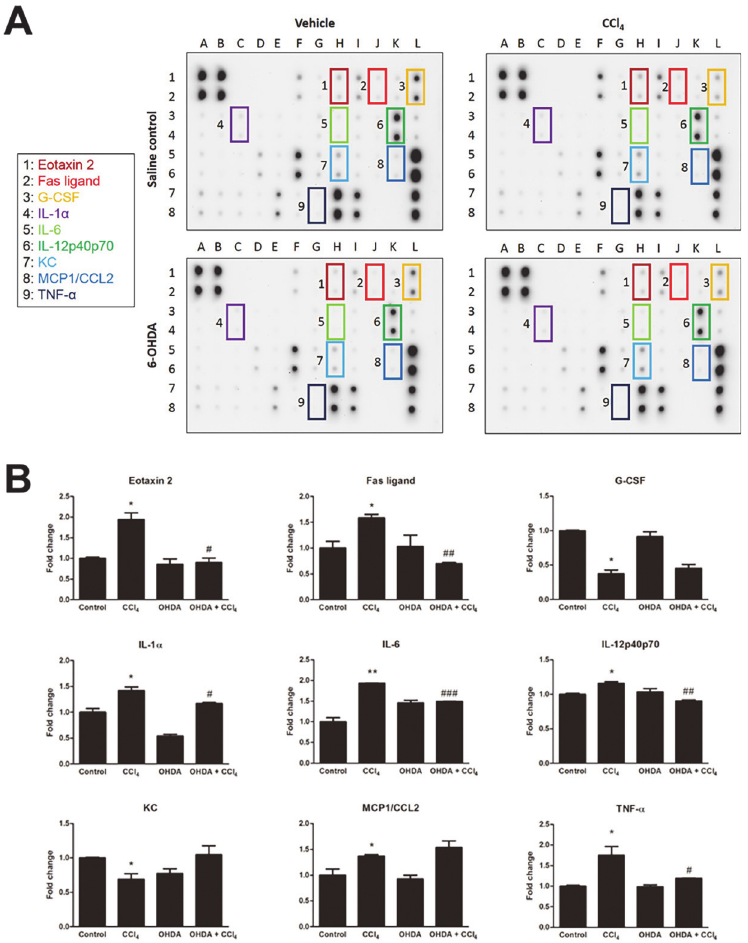
Fig 7. The effect of sympathetic denervation on CCl 4 -induced systemic inflammatory markers as measured by antibody array. (A) Inflammation array in serum from control, CCl 4 -, 6-OHDA-, and 6-OHDA/ CCl 4 -treated mice. Altered cytokines and chemokines are indicated by boxes. (B) Quantification of the expression of eotaxin-2/CCL24, Fas ligand, granulocyte colony-stimulating factor (G-CSF), interleukin (IL)- 1 α , IL-6, IL-12p40p70, keratinocyte-derived chemokine (KC), monocyte chemoattractant protein-1 (MCP-1/ CCL2), and tumor necrosis factor- α (TNF- α ) in each group. Data are presented as the fold of expression. Bars are mean ± SD for two replicated spots on the membrane. In all figures, significant differences are noted as * p < 0.05 vs. control, # p < 0.05 vs. CCl 4 , ** p < 0.01 vs. control, ## p < 0.01 vs. CCl 4 , and ### p < 0.001 vs. CCl 4